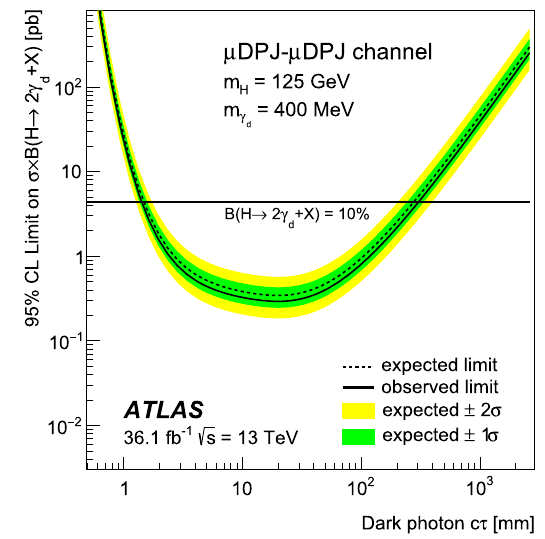
zontal lines correspond to the cross section times branching fraction for a value of the branching fraction of the Higgs boson decay into dark fermions of 10%